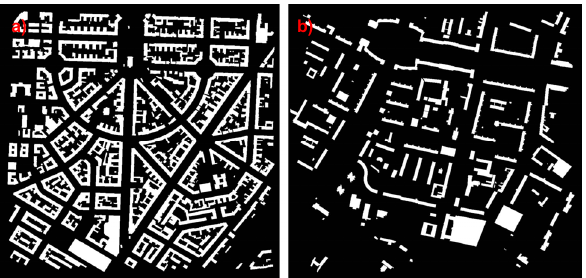
Figure 6. Test areas in Berlin that underwent Visual Impact Size analysis (VIS): a) parts of Friedenau District (about 1.0 km2); b) part of Friedrichshein District (about 1.0